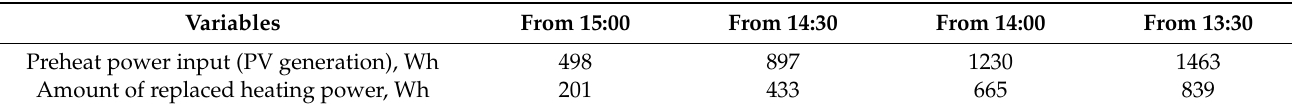
Figure 15. Simulated indoor air temperature profile by adjusting preheating beginning time. Table 3. Simulation results of house preheat